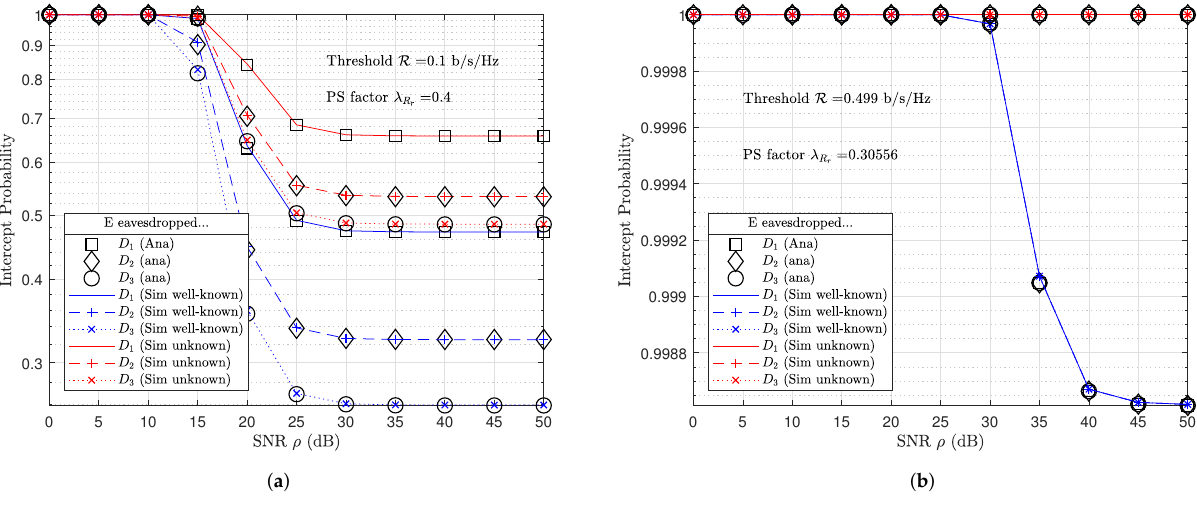
Figure 7. IP performance of cooperative NOMA-IoT network with jamming signal, ( a ) fixed PS factor = 0.4 and fixed bit-rate threshold R = 0.1, ( b ) optimized bit-rate threshold and PS λ R r